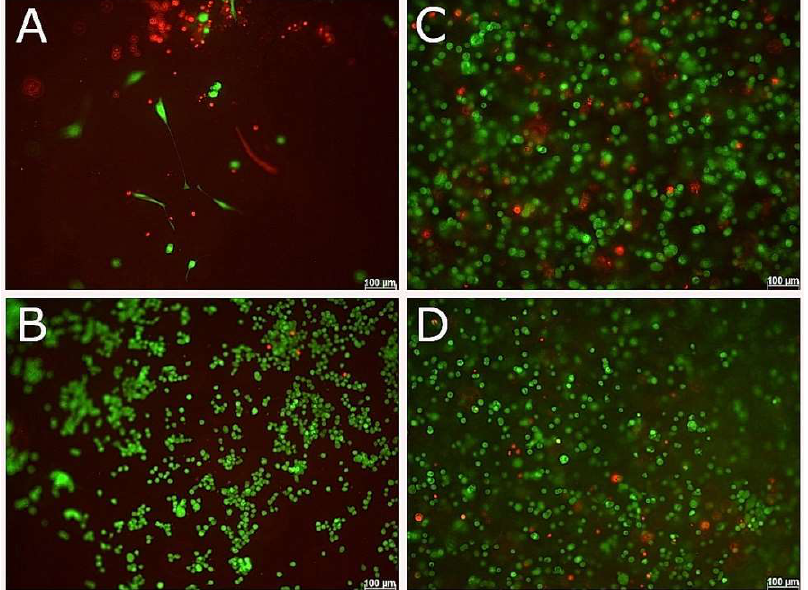
Figure 9. Live and Dead images of NSC-34 cells encapsulated in or surface seeded to 2.5/mL fish collagen UV crosslinked for 12 s at 12mW/cm 2 . Live and dead images taken of NSC-34 surface seeded to methacrylated fish collagen at day 7 ( A , B ) and encapsulated in methacrylated fish collagen at day 21 ( C , D ). Top and bottom rows correspond to cells cultured with differentiation media and growth media, respectively. Scale bars represent 100 µm.